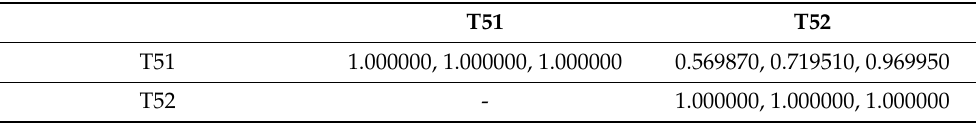
Table 6. Fuzzy aggregated pair-wise comparison matrix at level 2 for Attack